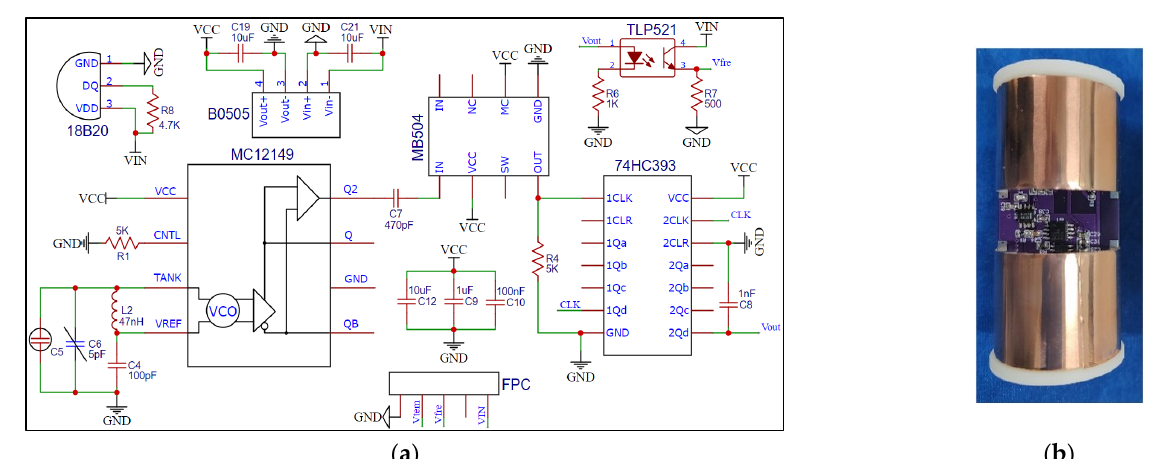
Figure 5. Overall hardware circuit diagram.